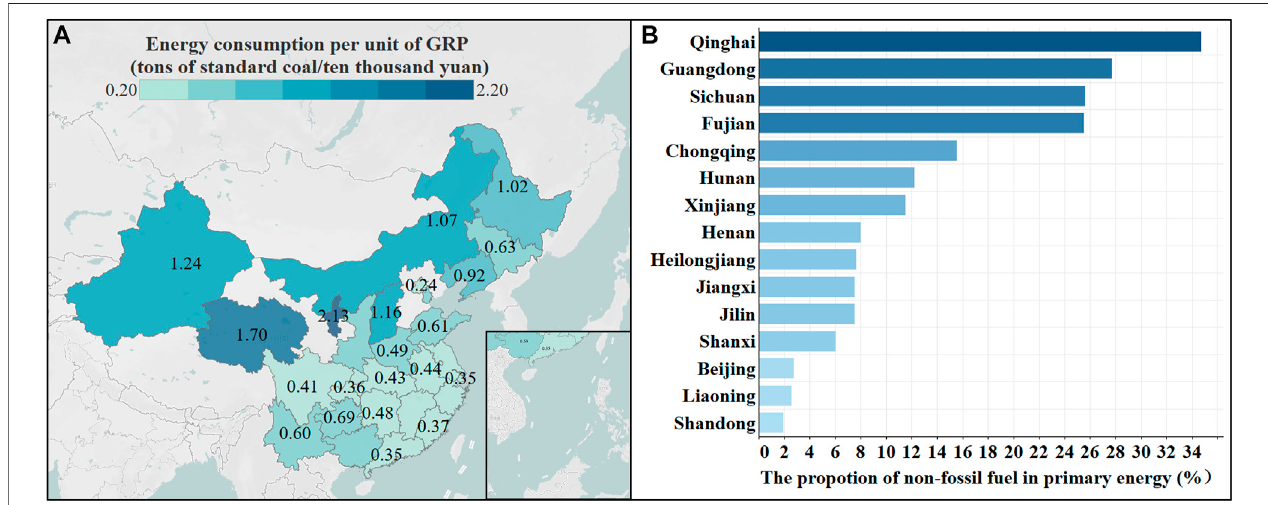
FIGURE 1 | (A) Energy consumption per unit of GRP and (B) the proportion of nonfossil fuel in primary energy of different provinces in China in 2017. Some provinces are not presented because of the data de fi ciency.